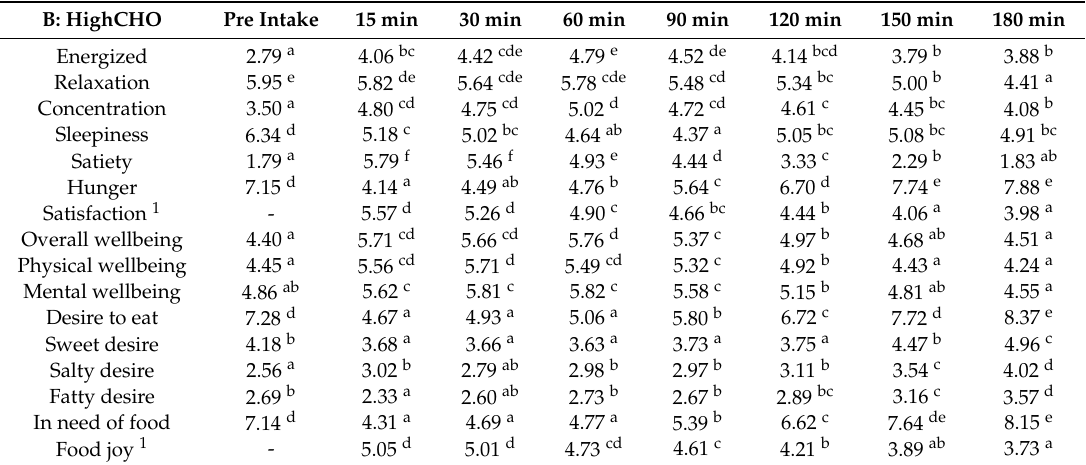
Table 6. Time e ff ects and means values ( n = 48) of post-ingestive sensations for HighCHO (B) at di ff erent time points after